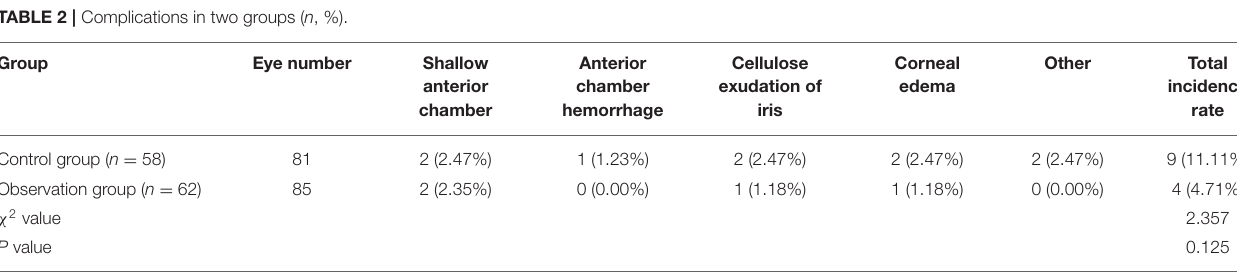
TABLE 2 | Complications in two groups ( n ,